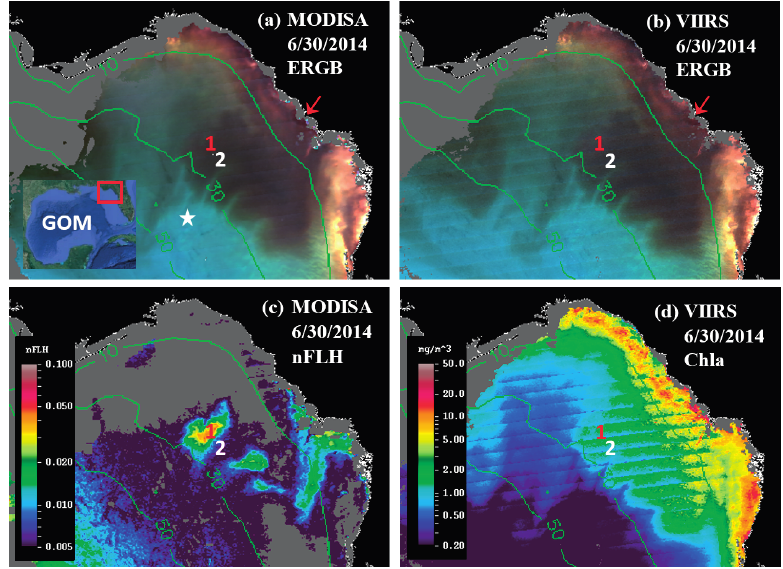
Figure 3. MODISA and VIIRS ERGB images on 30 June 2014 (19:00 GMT) in ( a ) and ( b ), respectively, showing dark water patches off the Suwannee River mouth (red arrows); ( c ) MODISA nFLH image (mW·cm − 2 · μ m − 1 ·sr − 1 ) showing distinctive high-nFLH